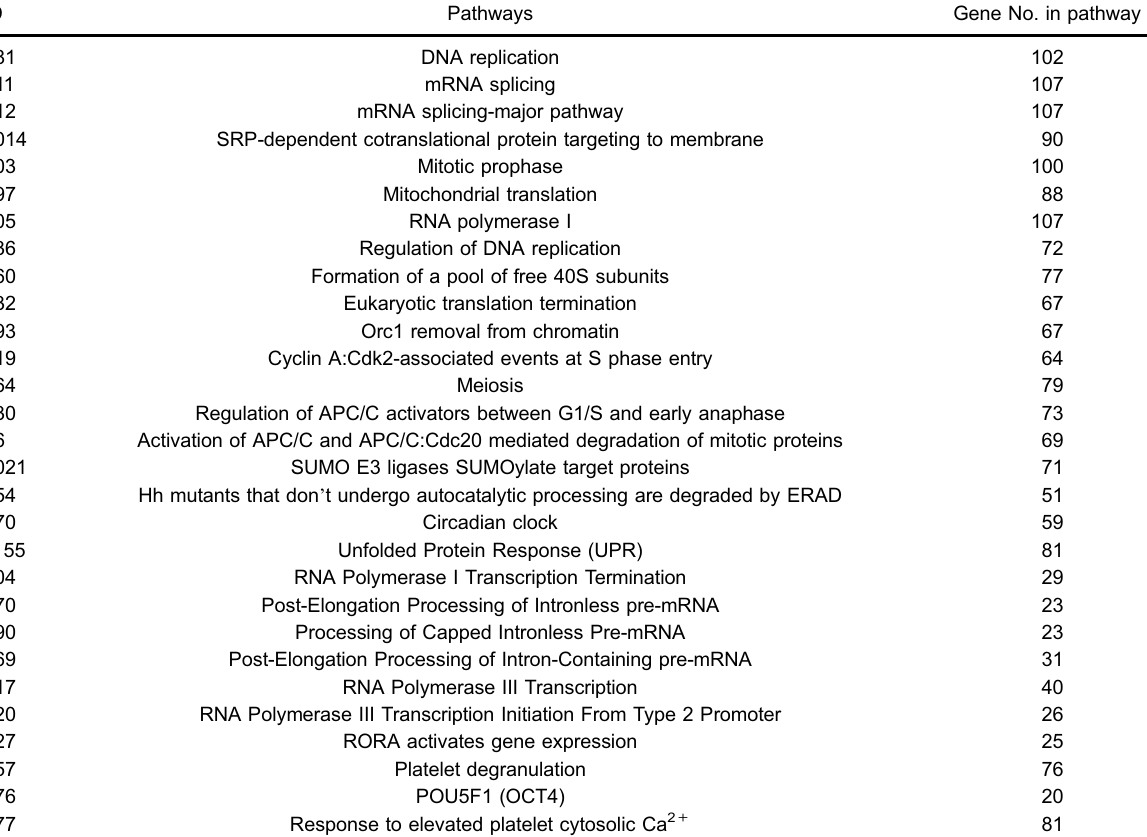
Table 2. Dysregulated pathways extracted from the pathway interaction network (PIN).